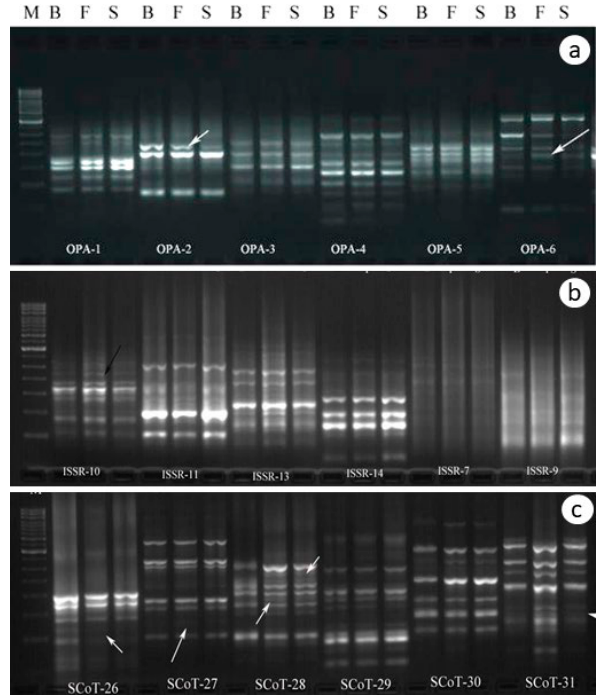
Fig. 4. Inheritance of pollen parent specific fragments (→) to C.